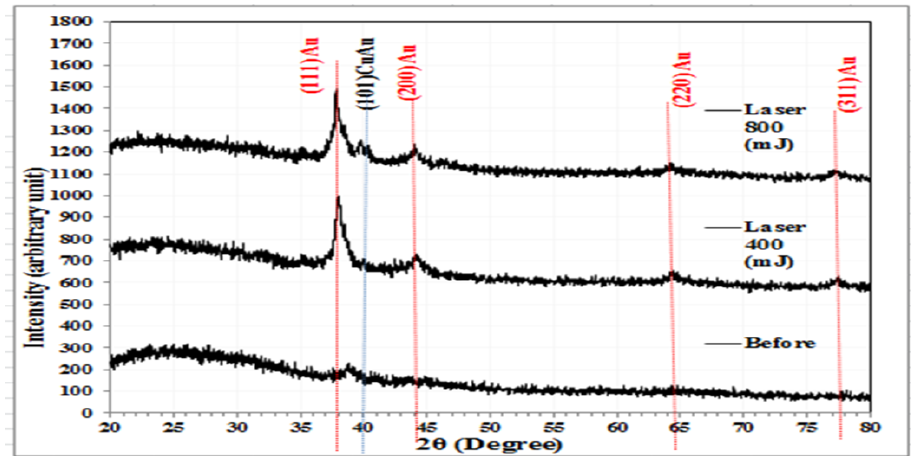
Fig. 10: X-ray diffraction pattern of B-alloy colloid NPs for exploding currents 160A and synthesized by (400 m J, 800 m J) laser energies